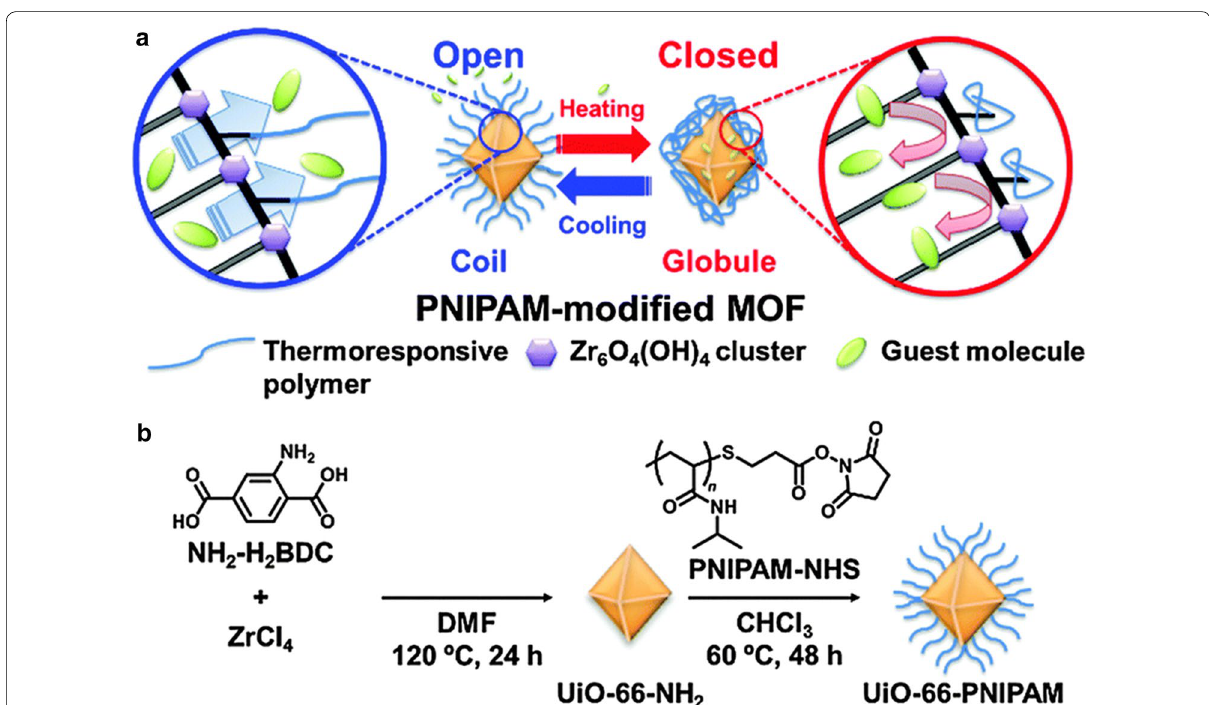
Fig. 7 a Schematic image of controlled release using MOF tethering PNIPAM. b Preparation method of UiO-66-PNIPAM (Reproduced from Ref. [71] with permission from the Royal Society of